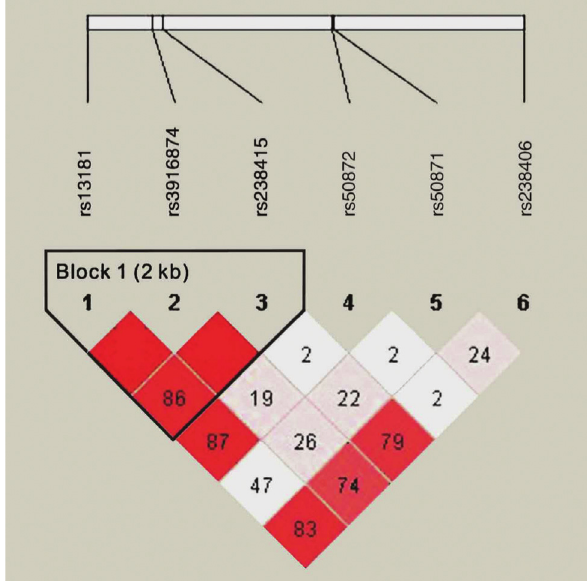
Figure1 -Linkagedisequilibrium(LD)plotoftheSNPsinXPD.SixSNP sites of XPD gene are shown in the upper part of the figure; the number in the box in the lower part shown the 100xD’value (D: linkage disequilib- rium parameter). A standard color scheme is used to display LD with brightredforverystrongLD(LOD (cid:2) 2,D’=1),whitefornoLD(LOD<2, D’ < 1), pink red for intermediate LD.